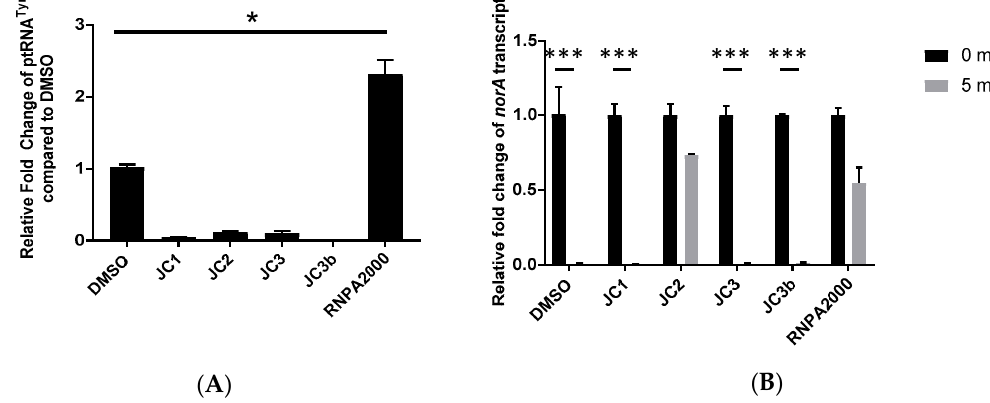
Figure 3. Quantitative RT-PCR measures of ptRNA Tyr accumulation ( A ) and norA transcript turnover ( B ) in S. aureus UAMS-1 cells treated with DMSO, JC class analogs, or RNPA2000. For ptRNA Tyr accumulation, samples were treated with DMSO, 1 × MIC JC class analogs (1 µ g · mL − 1 JC1, 0.5 µ g · mL − 1 JC2, 1 µ g · mL − 1 JC3 or 32 µ g · mL − 1 JC3b) or 1 × MIC RNPA2000 (16 µ g · mL − 1 ) for 1 h For norA transcript turnover, samples were treated with DMSO, 0.5 × MIC JC class analogs (0.5 µ g · mL − 1 JC1, 0.25 µ g · mL − 1 JC2, 0.5 µ g · mL − 1 JC3 or 16 µ g · mL − 1 JC3b) or 0.5 × MIC RNPA2000 (8 µ g · mL − 1 ) for 30 min prior to